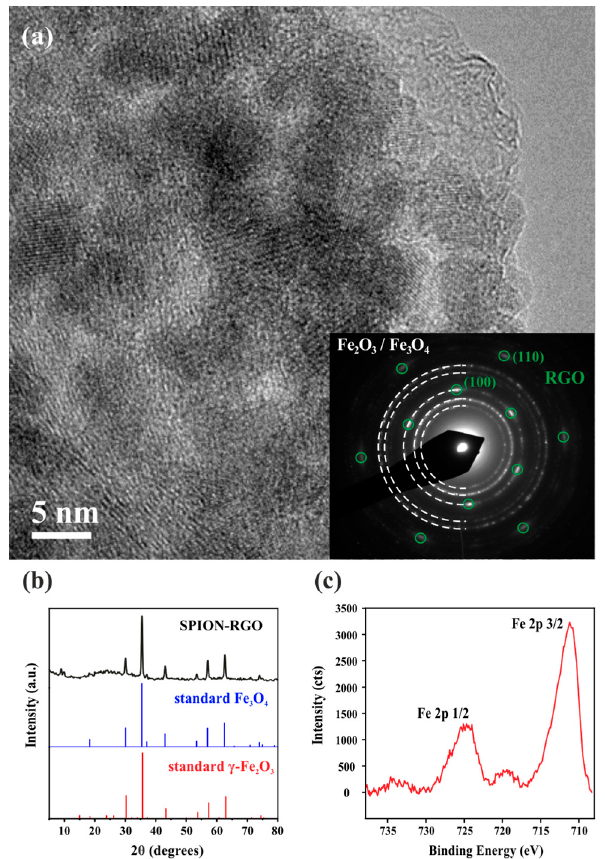
Figure 3. ( a ) HRTEM image of SPION-RGO and the corresponding SAED pattern (inset), ( b ) X-ray diffraction pattern of the hybrid material along with the standard diffraction patterns of Fe 3 O 4 (PDF#: 722303) and γ -Fe 2 O 3 (PDF#: 391346), and ( c ) high resolution Fe 2p X-ray photoelectron spectrum of SPION-RGO.